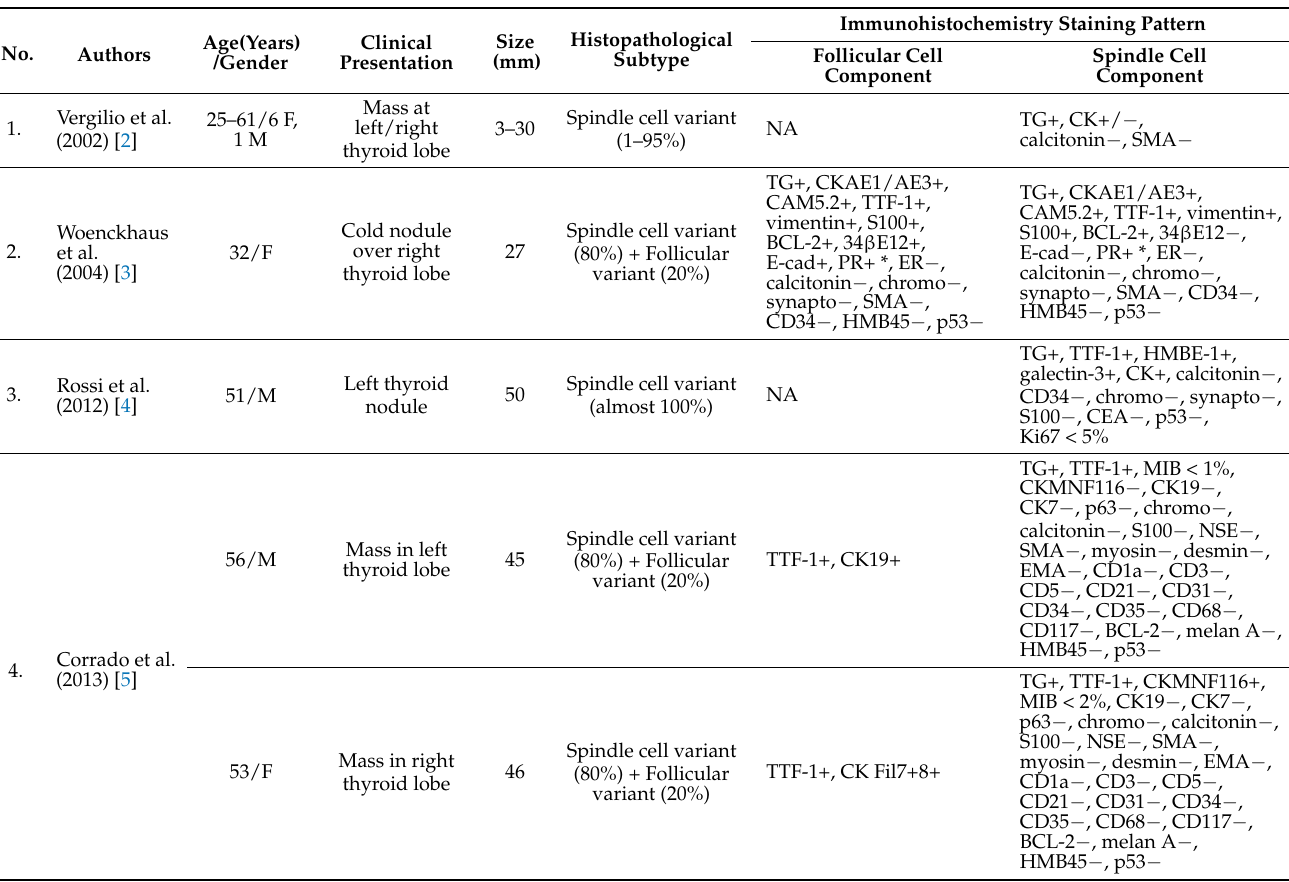
Table 1. Clinicopathological Features of Reported Cases on Papillary Thyroid Carcinoma with Spindle Cell